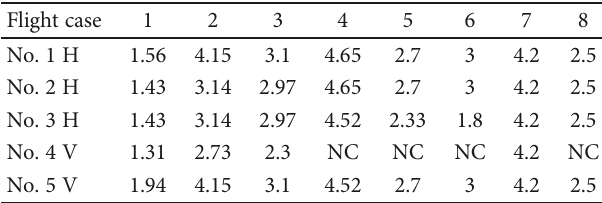
Table 8: Decision results in the close encounters.